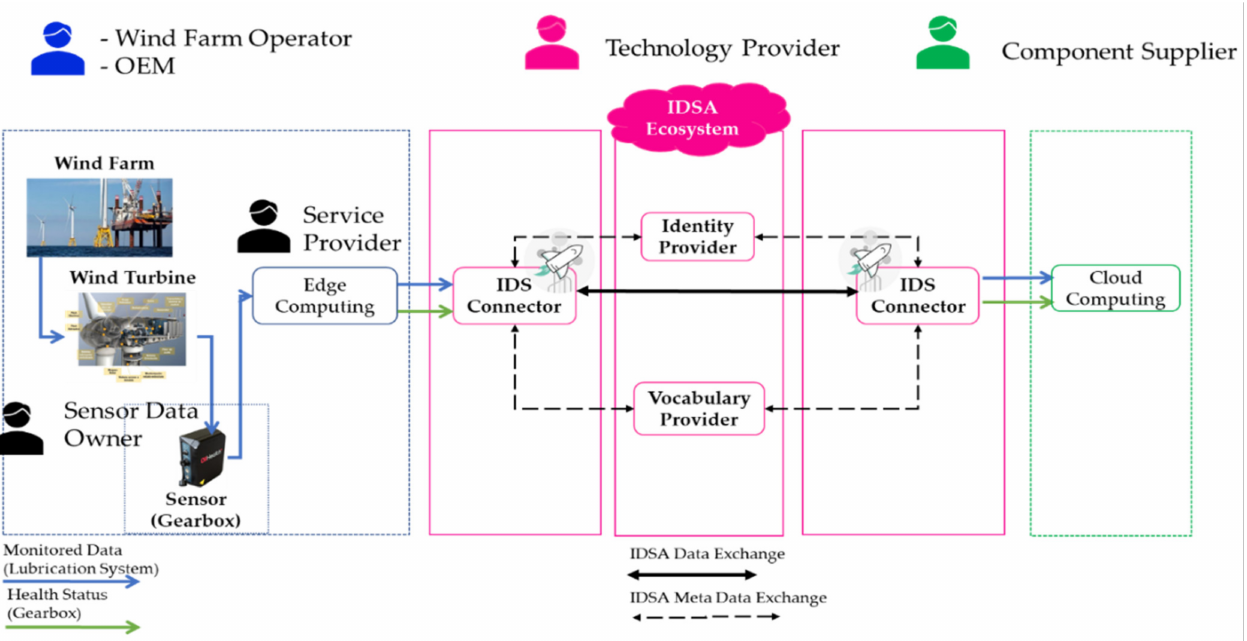
Figure 14. IDSA Wind Energy Use